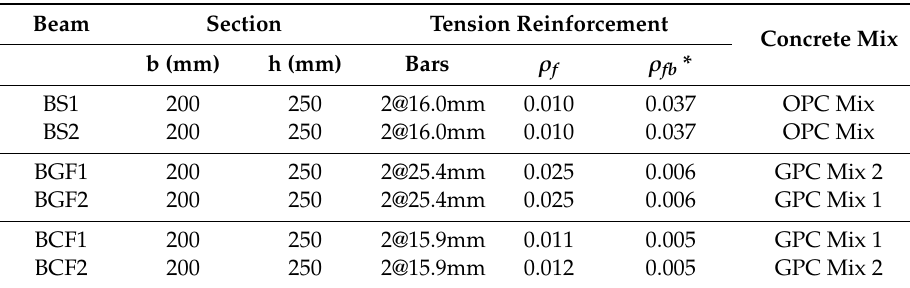
Table 3. Geometrical properties of